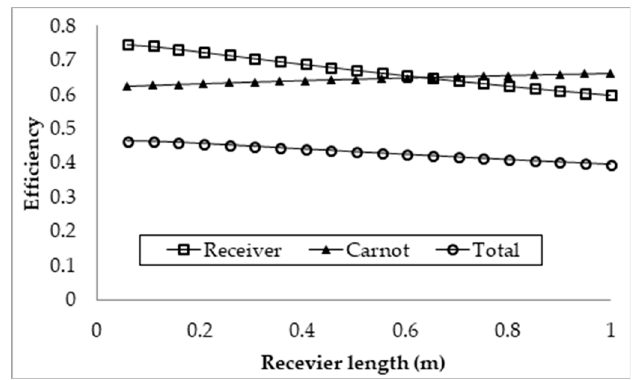
Figure 5. Effect of receiver length on the efficiency. Figure 5. E ff ect of receiver length on the e ffi